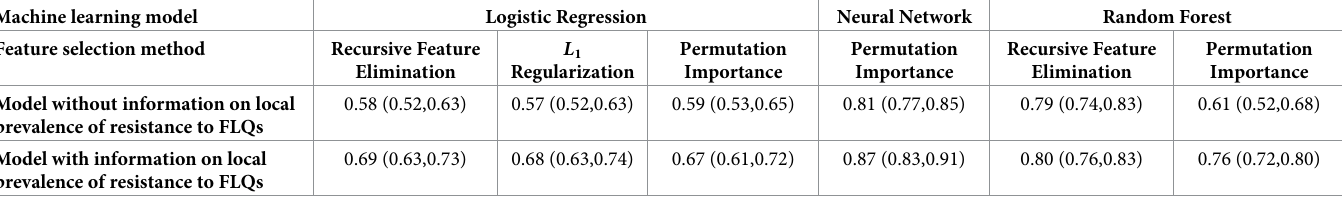
Table 2. The estimated optimism-corrected area under the receiver operating characteristic curve (OC-AUC-ROC), for predictive models developed by different machine learning algorithms and feature selection methods. Machine learning model Logistic Regression Neural Network Random Forest Feature selection